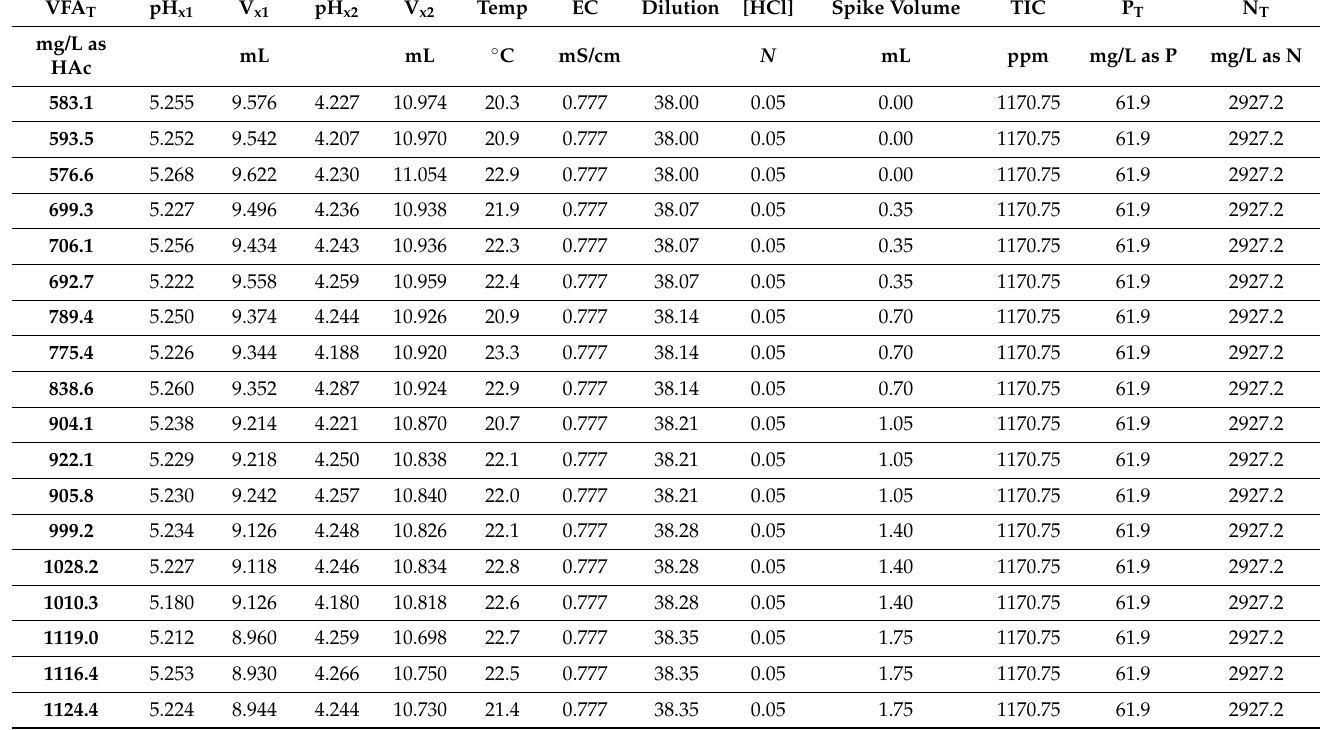
Table A4. Results of Acre VFA T +